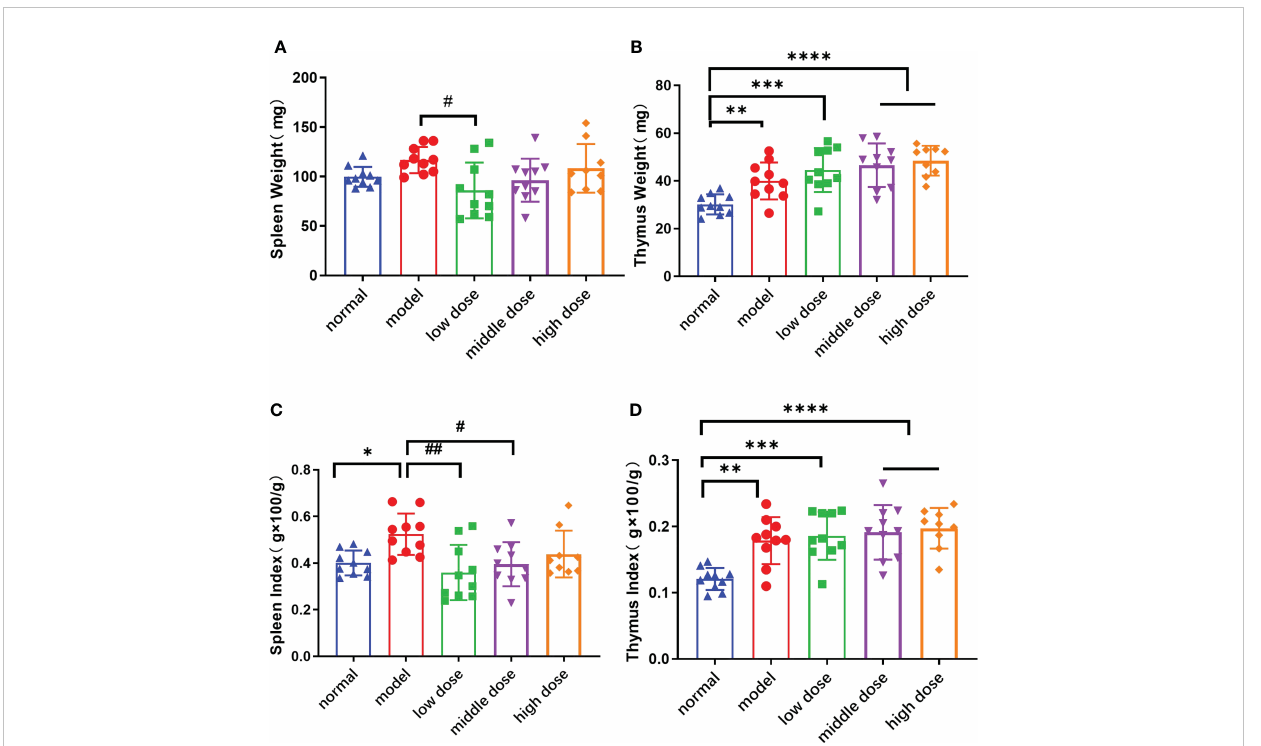
FIGURE 6 The weight and Index Score of Spleen/Thymus in each group at the 20th week. (A) : the spleen weight; (B) : the thymus weight; (C) : the spleen index, spleen weight (g)x100/mouse weight(g); (D) : the thymus weight(g) x100/mouse weight(g). Data are presented as mean ± SD; *p ≤ 0.05, **p ≤